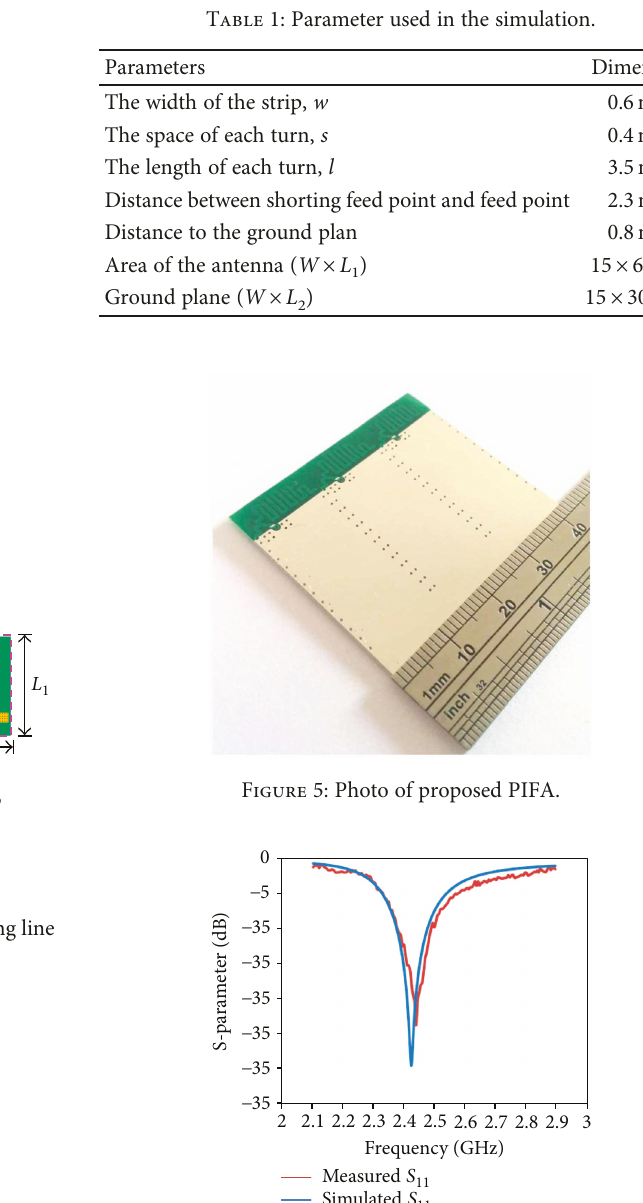
) with sinusoidal current distribution. (b) Antenna (length =0.1 λ 1